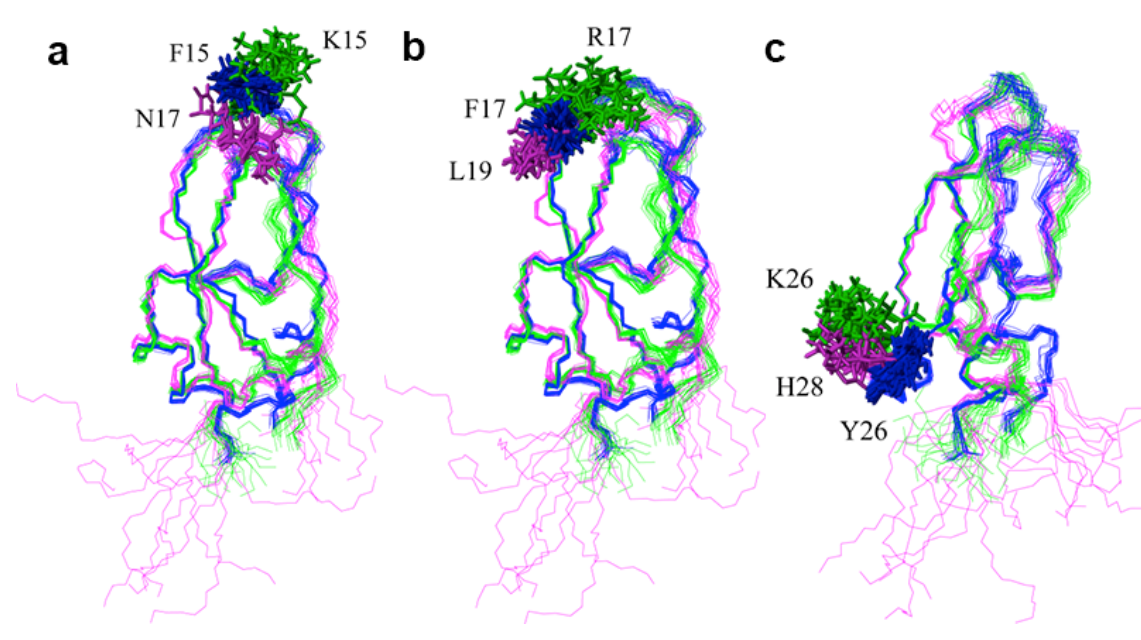
Figure 5. Side chain conformations of Phe15, Phe17, and Tyr26 in NACI (blue), and of corresponding residues in homologous structures. i.e. , Lys15, Arg17, and Lys26 in BPTI (green) and Asn17, Leu19, and His28 in BF9 (magenta). ( a ) Phe15 in NACI, Lys15 in BPTI, and Asn17 in BF9. ( b ) Phe17 in NACI, Arg17 in BPTI, and Leu19 in BF9.